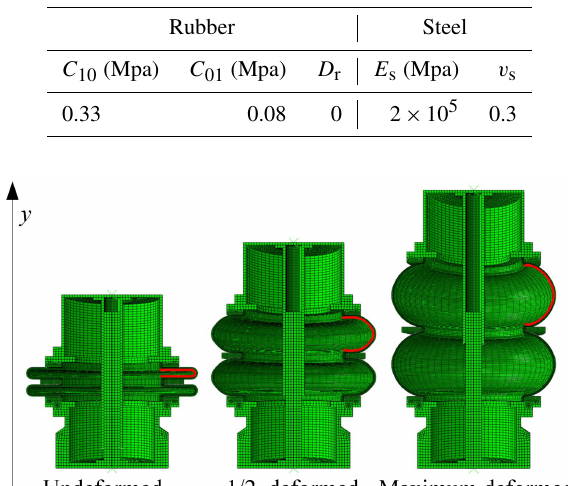
Figure 5. Deformation results.